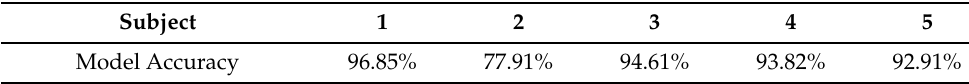
Table 1. Model accuracy for each individual subject.